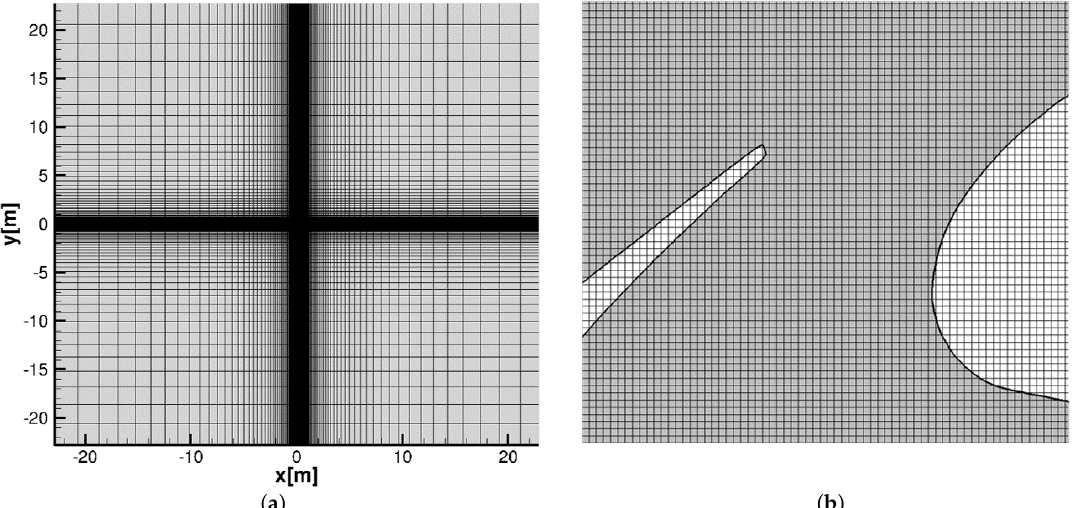
Figure 5. Computational grid around a 30P30N high-lift airfoil configuration. ( a ) Grid in all the computational domain; ( b ) Computational grid around the trailing edge of the slat and the leading edge of the main element.